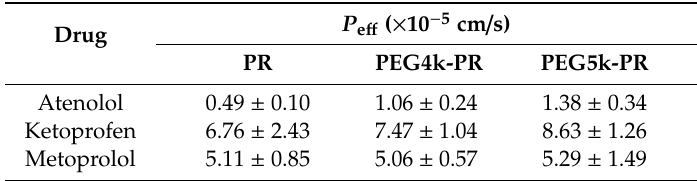
Table 4. E ff ective intestinal membrane permeability ( P e ff ) (cm / s) values of atenolol, ketoprofen, and metoprolol corrected by di ff erent markers in rat complete small intestines using the recirculation Table 4. Effective intestinal membrane permeability ( P eff ) (cm/s) values of atenolol, ketoprofen, and perfusion method. Data are shown as mean ± SD, n = metoprolol corrected by different markers in rat complete small intestines using the recirculation perfusion method. Data are shown as mean ± SD, n = 3.